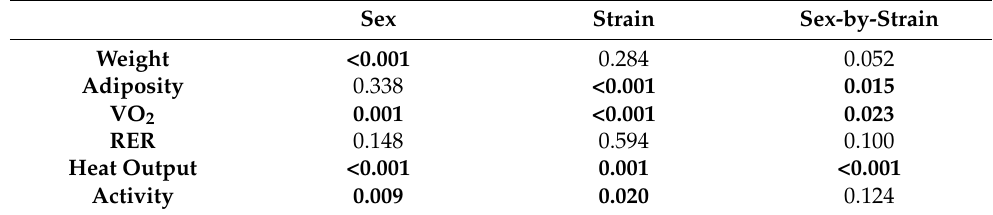
Figure 1. Effects of sex and strain on metabolic traits. Body weight ( A ) and adiposity ( B ) were measured at 28 weeks of age. VO 2 ( C ), RER ( D ), heat output ( E ), and activity ( F ) were measured at 18 weeks of age, during a 48-h period when mice were housed in Phenomaster metabolic cages; N = 5/sex and strain group, avg. ± std. dev. Dots represent individual mice within sex-by-strain combination. Horizontal bars represent pairwise comparisons performed using Tukey’s HSD post hoc analysis; * p < 0.05, ** p < 0.01, and *** p < 0.001. Table 1. p -values for effects of sex, strain, and sex-by-strain interaction on weight and